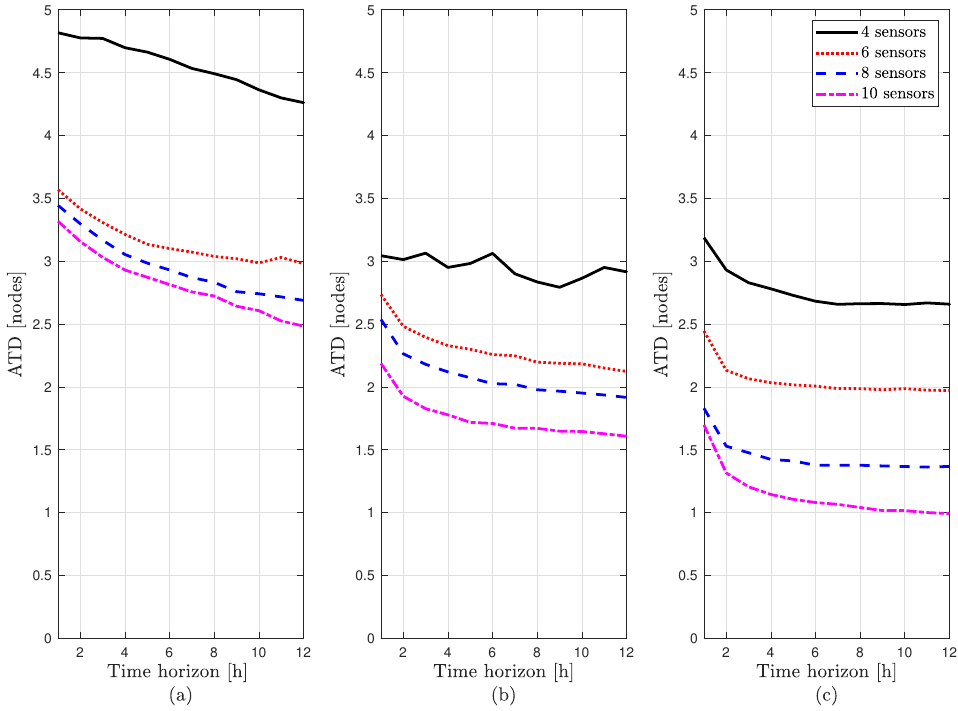
Figure 5. Evolution of the ATD between the methods: ( a ) using the Kriging interpolation method presented in [18], ( b ) using the new leak localization method with the same sensor configurations as in [18] and ( c ) using the new localization method with sensor configurations of Table